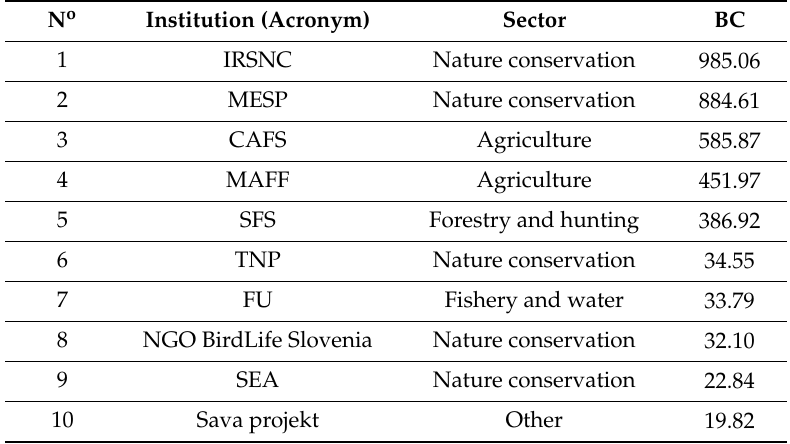
Table A2. Top 10 in the betweenness centrality values (BC) for institutions in the undirected network of